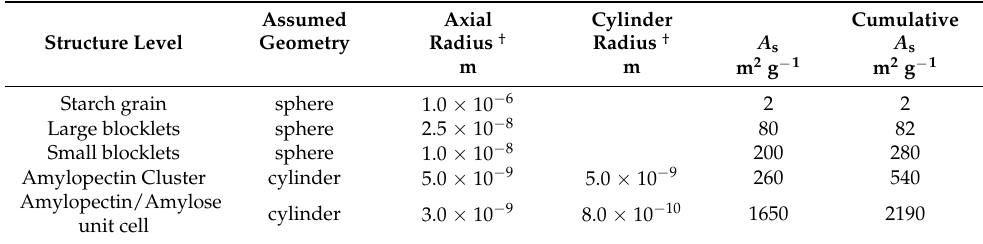
Table 7. Calculated specific surface area ( A s ) and cumulative specific surface area based on corn starch constituent geometries approximated as spheres or